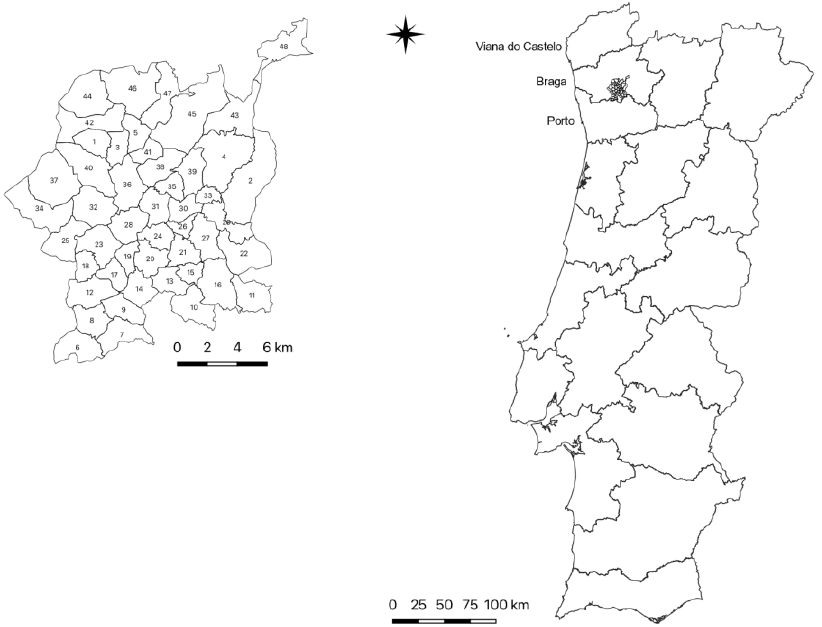
Figure 1. The municipality of Guimarães is in Northern Portugal, in the district of Braga, and is